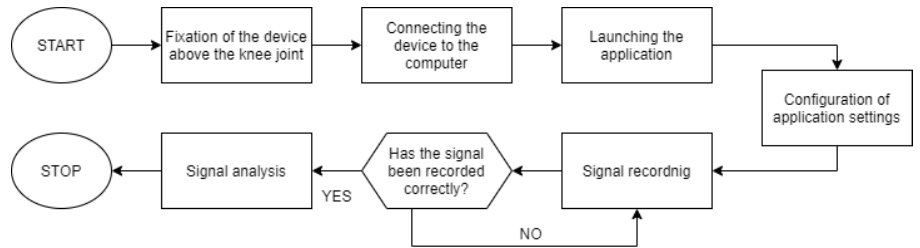
Figure 4. Block diagram describing the operation of the